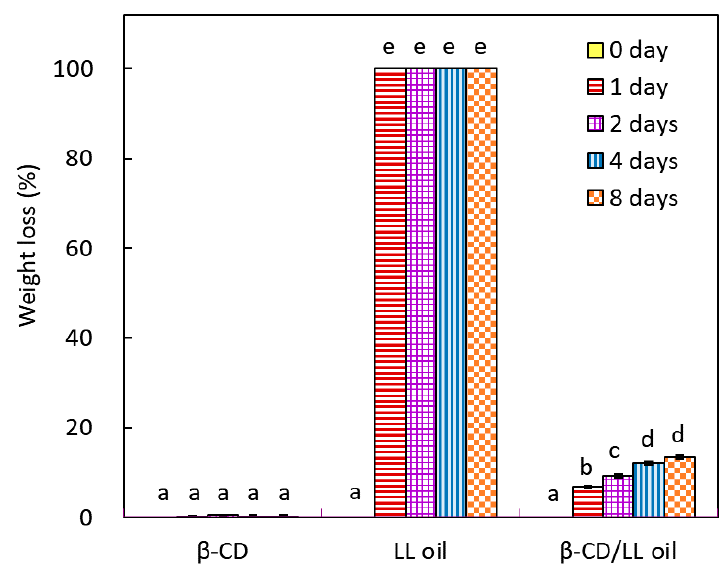
Figure 3. Changes in weight loss of leaf essential oil microcapsules during the dry-heat aging period. β -CD: β -cyclodextrin; LL oil: C. osmophloeum leaf oil; β -CD/LL oil: leaf oil microcapsules; different letters (a–e) in the figure refer to the statistically significant difference at the level of p < 0.05 according to the Scheffé’s test.